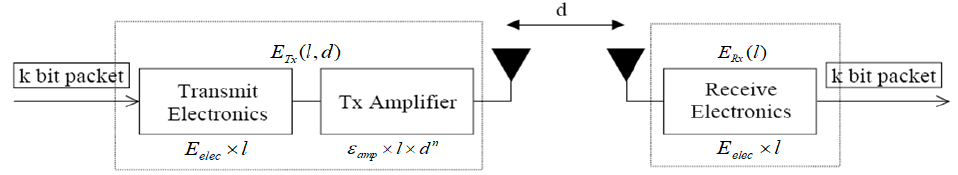
Figure 2. Energy Figure 2. Energy model.